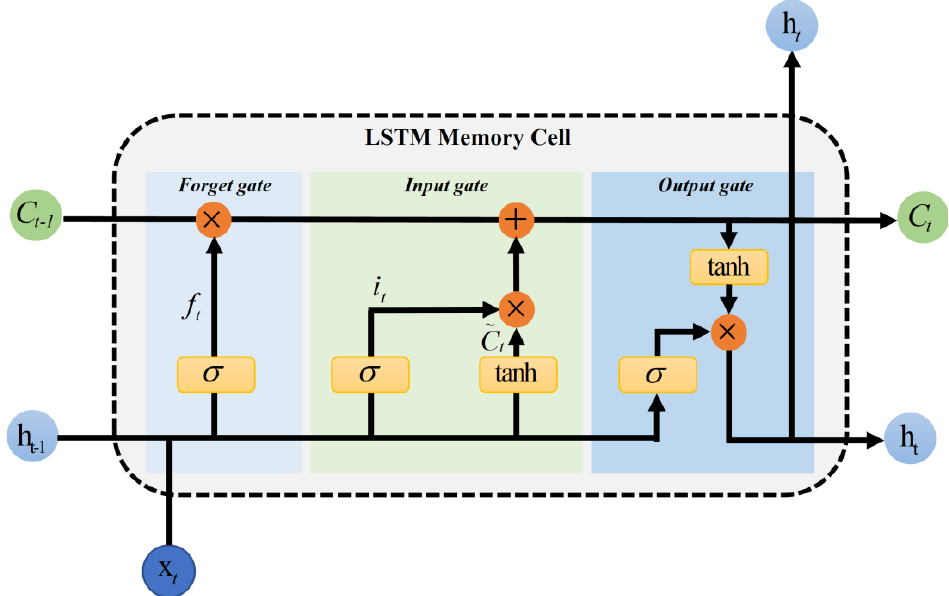
Figure 3. LSTMs Memory Cell. where σ represents sigmod activation function, tanh is an activation function, × represents multiplication, + represents addition. Other variables are temporal characteristic information.